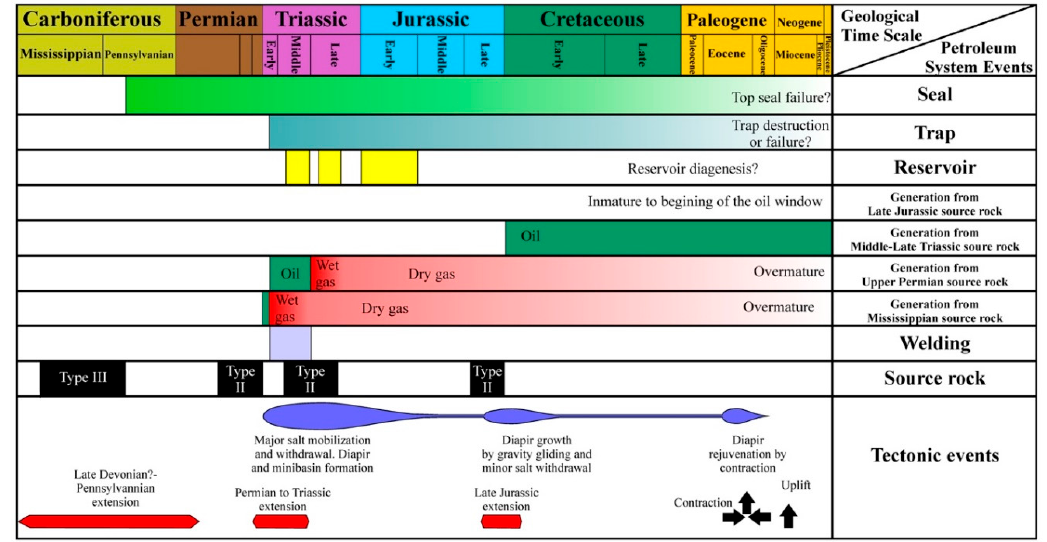
Figure 11. Petroleum systems chart for the Nordkap Basin. Insights from the modeling results are incorporated in the chart.